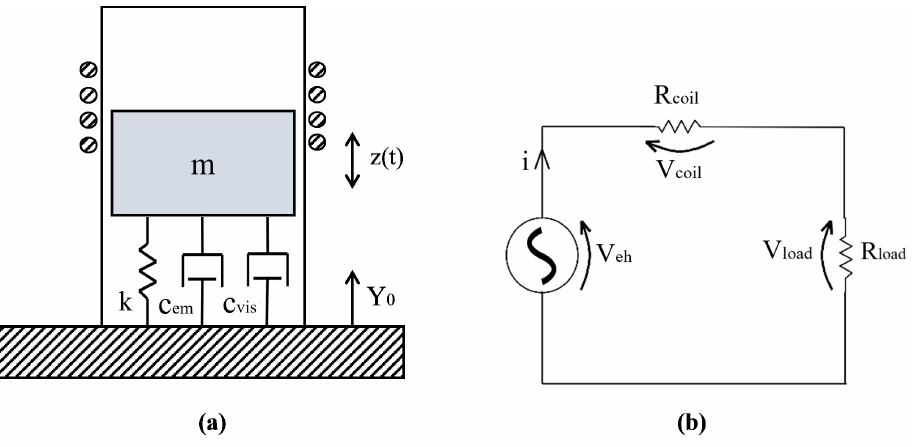
Figure 2. ( a ) Scheme of harvester mechanical subsystem. ( b ) Scheme of harvester electric